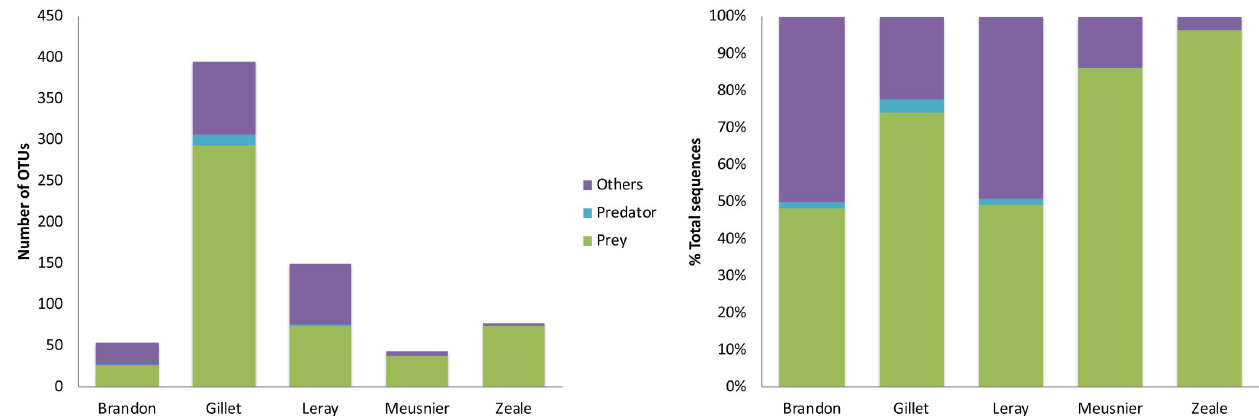
Fig 3. Species-level taxonomic assignment of OTUs obtained for each primer set. Number of OTUs and % of total sequences obtained.